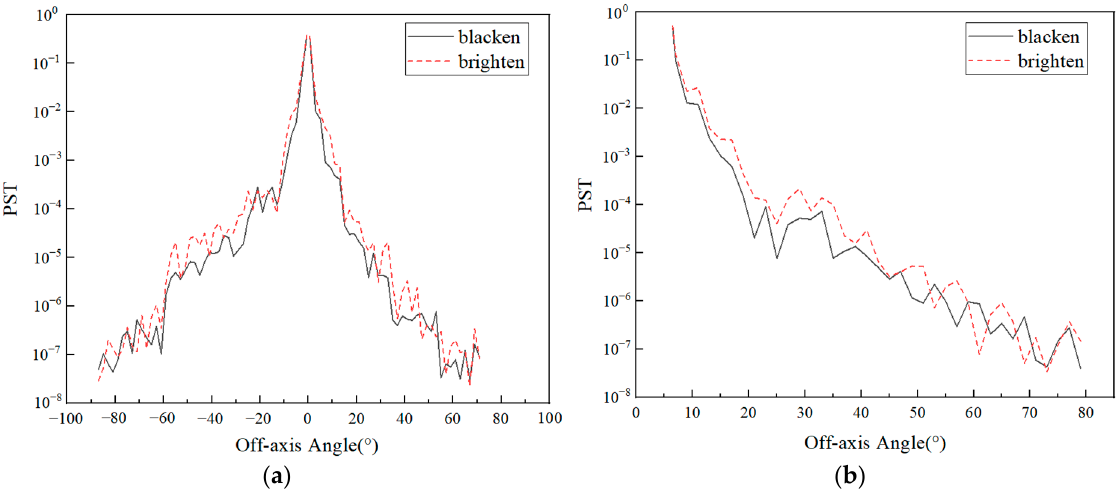
Figure 11. PST curves of THz with inner wall brighten or blacken. ( a ) Y direction; ( b ) X direction.